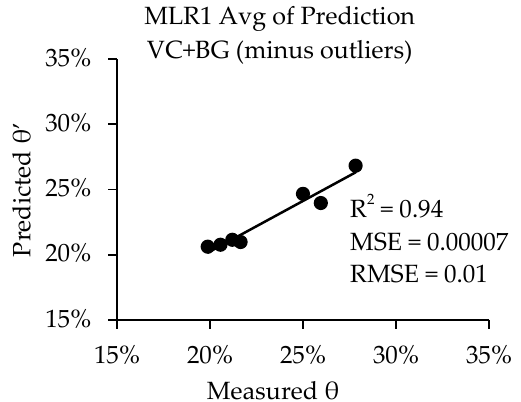
* Table Legend: Bare Ground (BG), Region of Interest (ROI), Vegetation Covered (VC), Average (Avg.), Volumetric Soil Moisture Content (VSMC), and Root Mean Square Error (RMSE). The averages of the predicted θ ’ were then compared with the average ground truth θ extracted from the respective ROIs. For instance, for the Metro Site ROI#1 location, the averages of 44 θ ’ predictions were taken and compared with the corresponding average measured θ . The comparison between the averages of the predicted volumetric soil moisture content ( θ ’) and measured θ for MLR1 after removing the results from outlier data points (Metro ROI#3 and Terry Road ROI#3) is presented in Figure 16. Although the coefficient of determination (R 2 ) was an excellent 0.94, it is not the best metric for measuring model prediction performance. Alternatively, MSE and RMSE are better prediction performance metrics, which are excellent for MLR1, as shown in Figure 16.